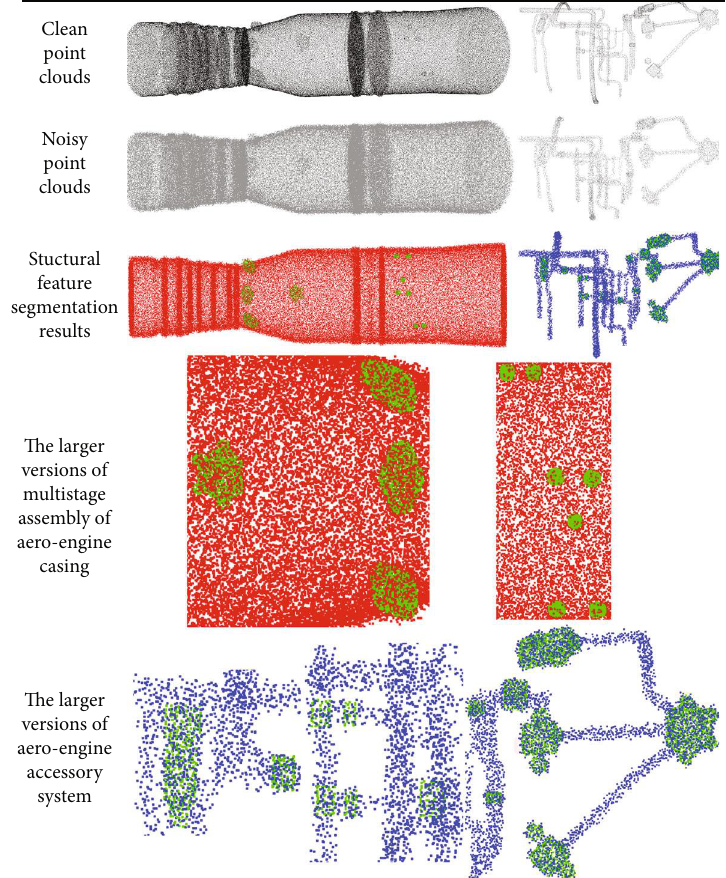
Figure 6: The structural feature segmentation results of aero-engine pro fi le point cloud. Green means complex shape feature data. Red means casing feature data and blue means pipeline feature data.